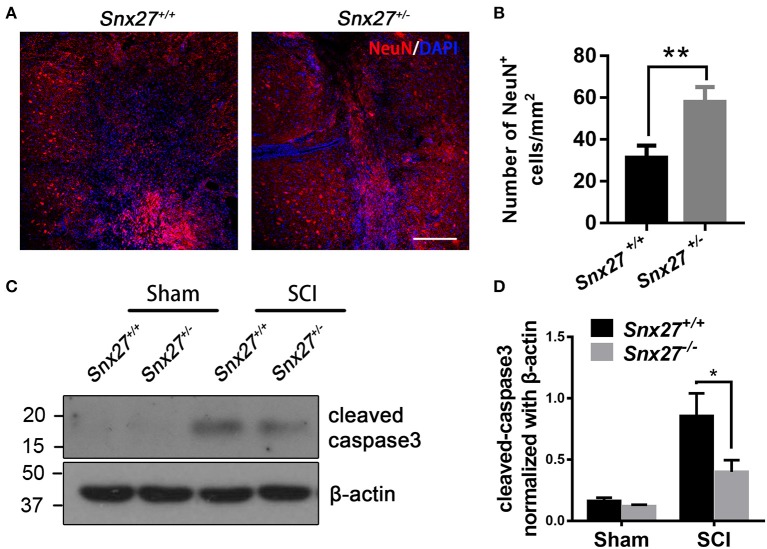
SNX27 haploinsufficiency prevents neuronal death and caspase-3 activation after SCI. (A) Representative images of the lesion center in the spinal cords from Snx27+/+ mice and Snx27+/− mice 7 days post injury, Scale bar = 200 μm. (B) NeuN+ cell quantification of the lesion center in the spinal cords from Snx27+/+ mice and Snx27+/− mice 7 days post injury, n = 4. (C) Western blot analysis of cleaved caspase-3 levels in the spinal cord of Snx27+/+ mice and Snx27+/− mice 3 days post injury. (D) Quantitative analysis of cleaved caspase-3 expression in the spinal cord of Snx27+/+ mice and Snx27+/− mice 3 days post injury, n = 4. Values are expressed as mean ± SEM and were evaluated by Student's independent sample t-test. *p < 0.05, **p < 0.01.